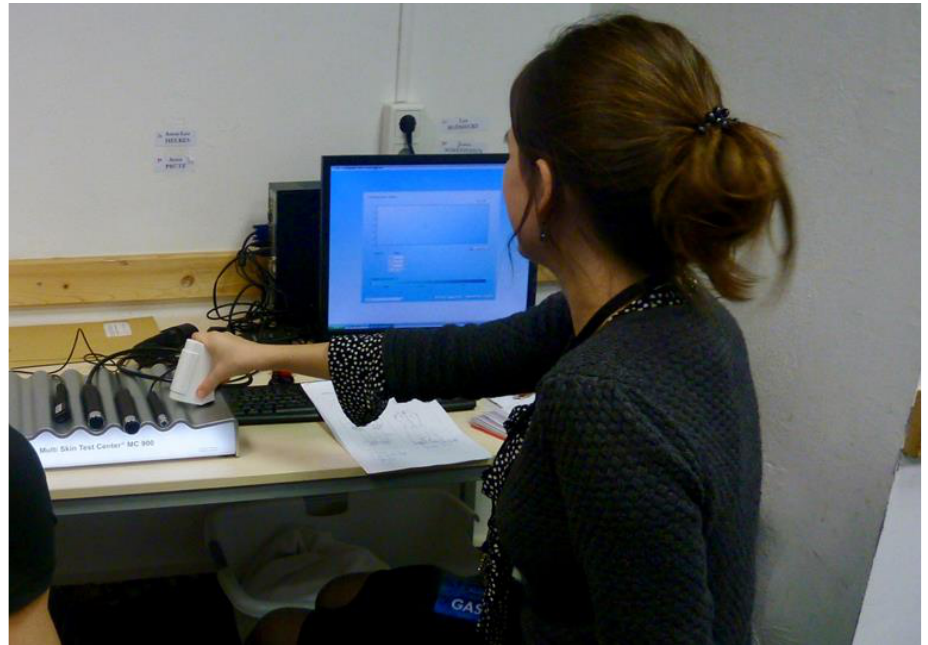
Figure 1. Carrying out the skin analysis on professional dancers.